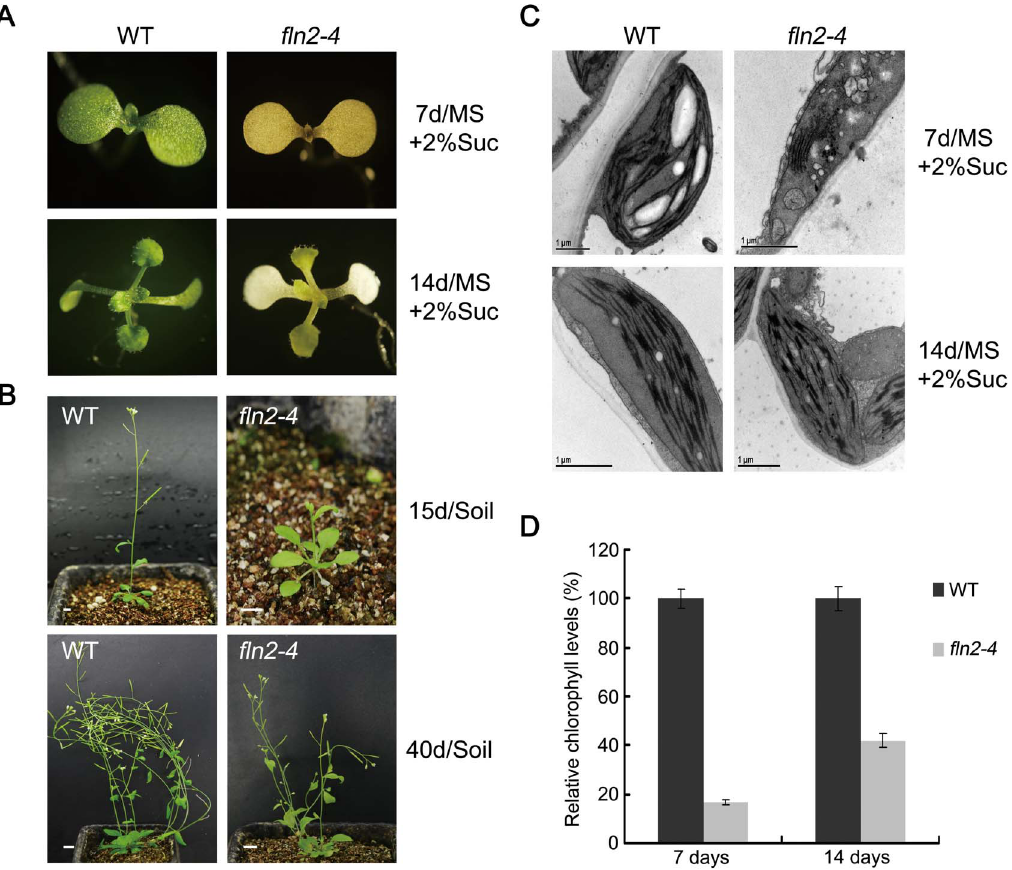
Figure 4. Alterations to seedling development in fln2–4 plants. (A) The phenotypes of WT and fln2–4 plant grown on 2% sucrose-containing MS medium for 7 days and 14 days. (B) The phenotypes of WT and fln2–4 plants grown in soil after growing on sucrose-containing medium for 14 days. Bars represent 1 cm. (C) Chloroplast ultrastructure in 7-day-old WT, 7-day-old fln2–4 plants, 14-day-old WT and 14-day-old fln2–4 plants. All of these plants grew on sucrose-containing medium. Scale bars: 1 m m. (D) The relative chlorophyll levels in WT and fln2–4 seedling during growth on sucrose-containing MS medium. The values presented are averages of three replicates 6 SD.